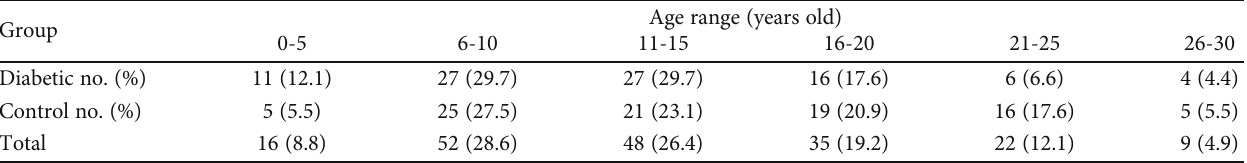
Table 2: Age range among the groups.